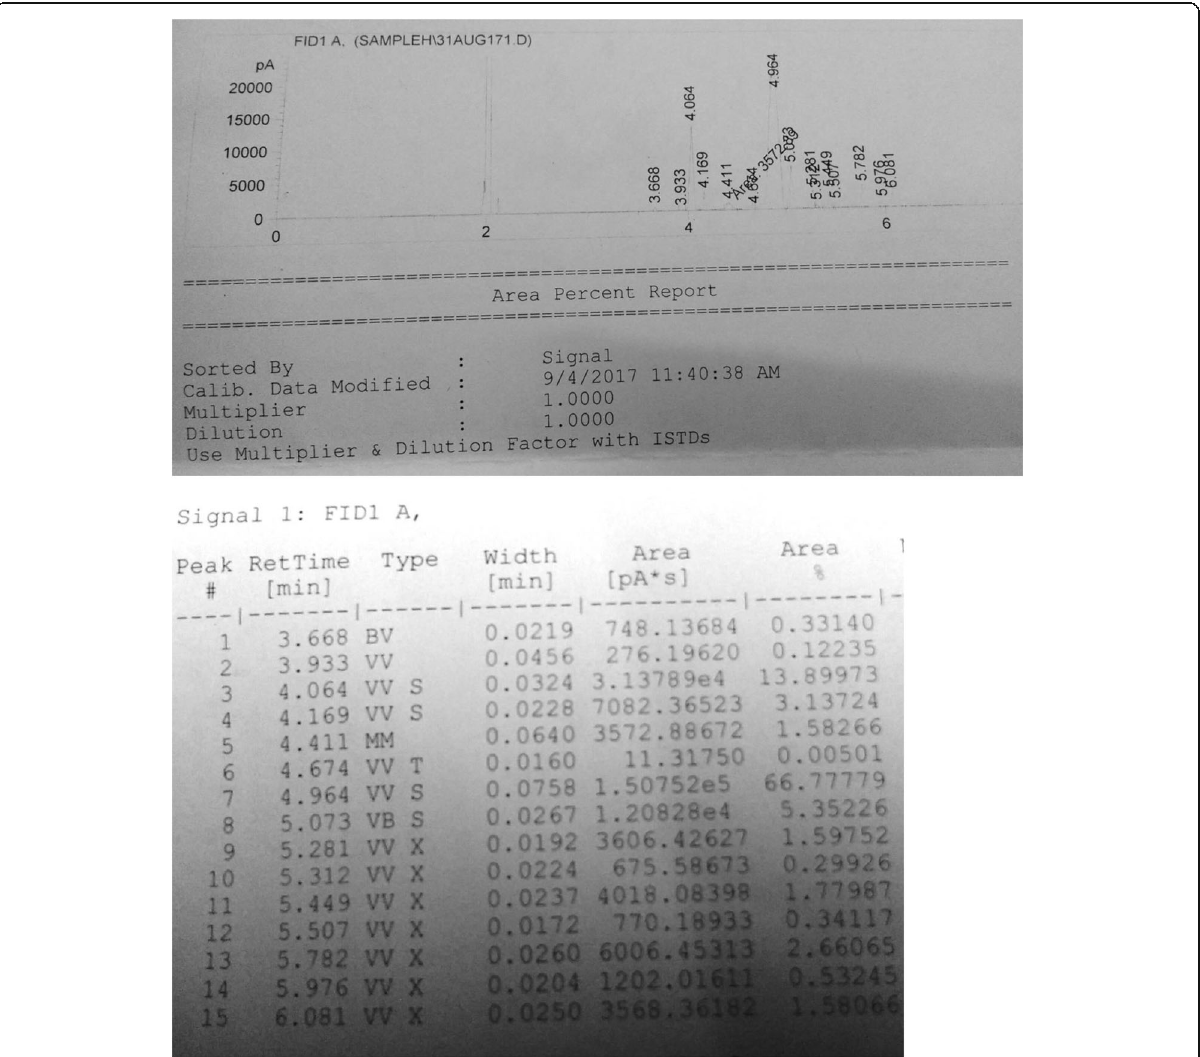
Fig. 1 Gas Chromatography of Eucalyptus Essential Oil. A Dose Dependant hepatoprotective and nephroprotective activity of eucalyptus oil on Streptozotocin induced diabetic mice